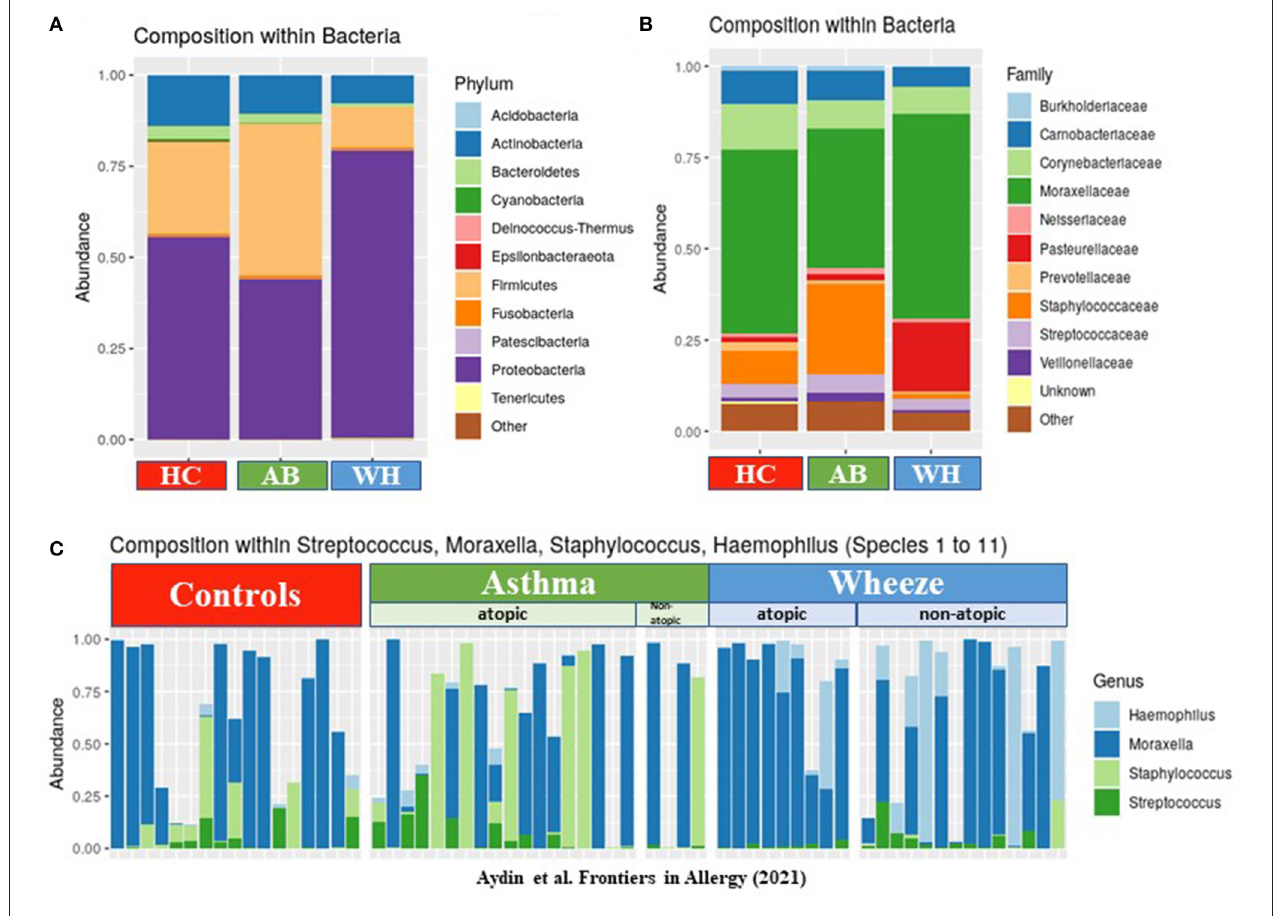
FIGURE 1 | The composition of bacteria in different disease groups. (A) The y -axis shows the abundances of each phylum level. Proteobacteria were highly abundant in WH, whereas Firmicutes , Cyanobacteria , and Actinobacteria were commonly more colonized in AB ( n = 64). (B) This figure presents the genera level abundances of bacteria. (C) The relative abundance levels of Moraxella (and other genus found by cultural approach) are presented in three different groups: HC, AB, and WH and subclassified in atopic/non-atopic AB and WH (AB, Asthmatics; WH, Wheezers; HC, Healthy